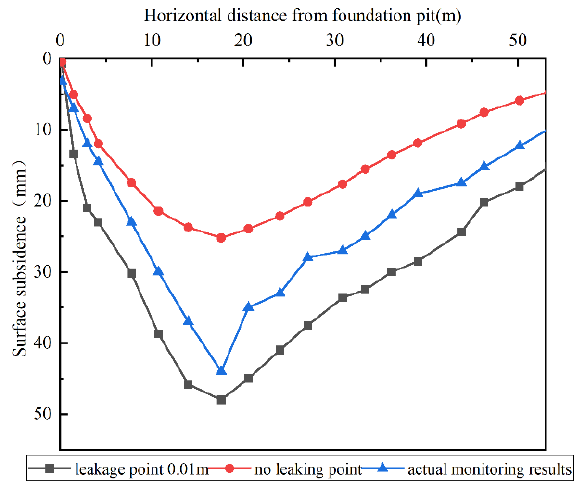
Figure 28. Comparison between numerical simulation and measured surface settlement.